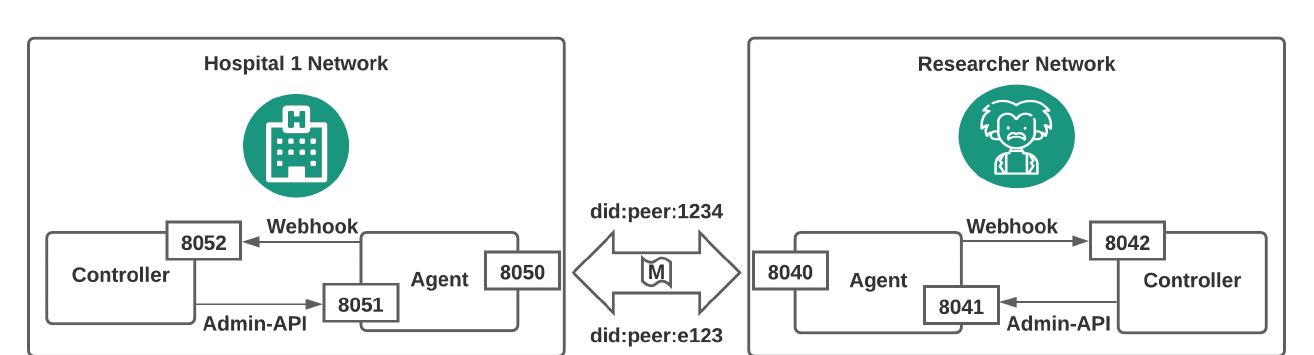
Figure 3. Networking communication